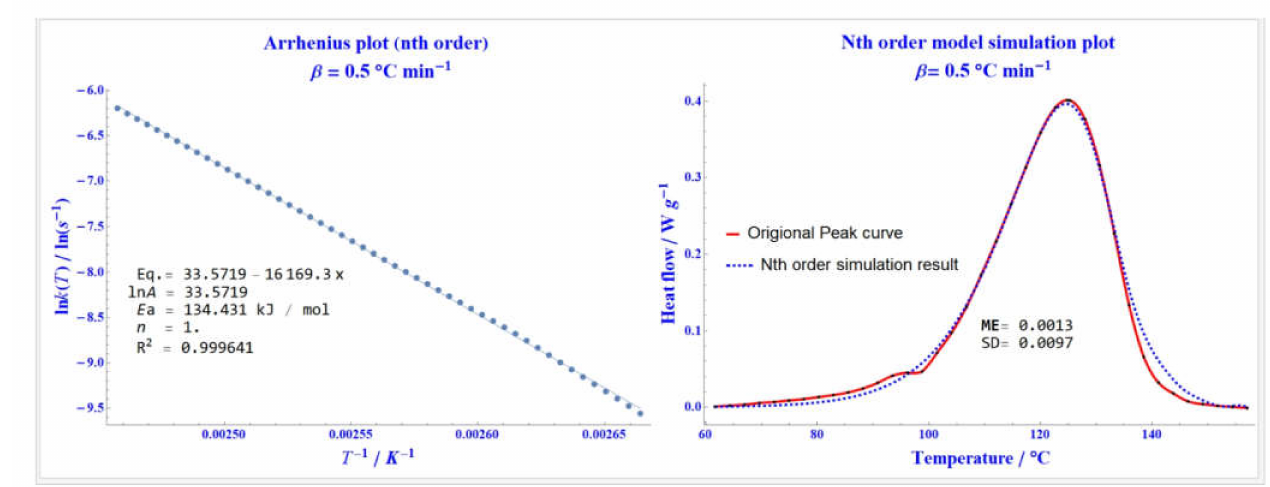
Figure 5. The Arrhenius plot showed the left side was derived by the B/D method, the right side was the real-time dynamic simulation curve which the curve was plotted by fitting the derived kinetic parameters into the DSC measurement records { T , α